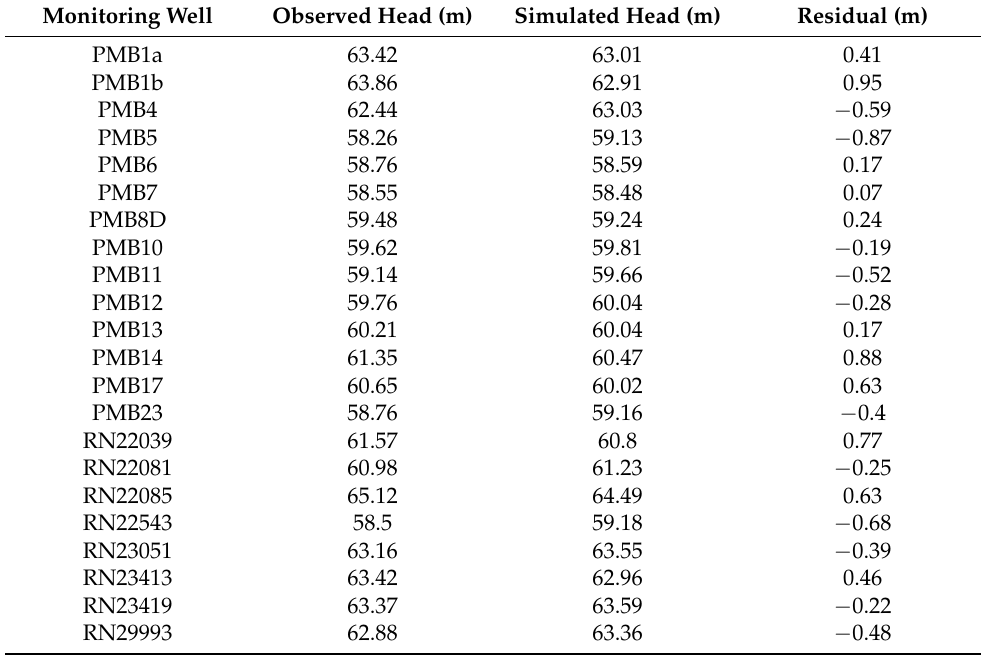
Table 4. Validation of hydraulic head values for 2015 (values in m AHD). Monitoring Well